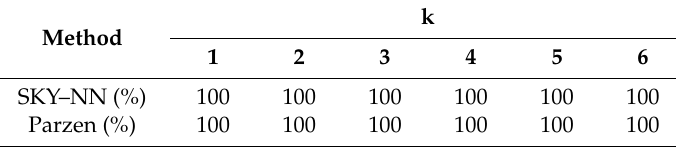
Table 15. Smart skyline on the synthetic Dataset II.